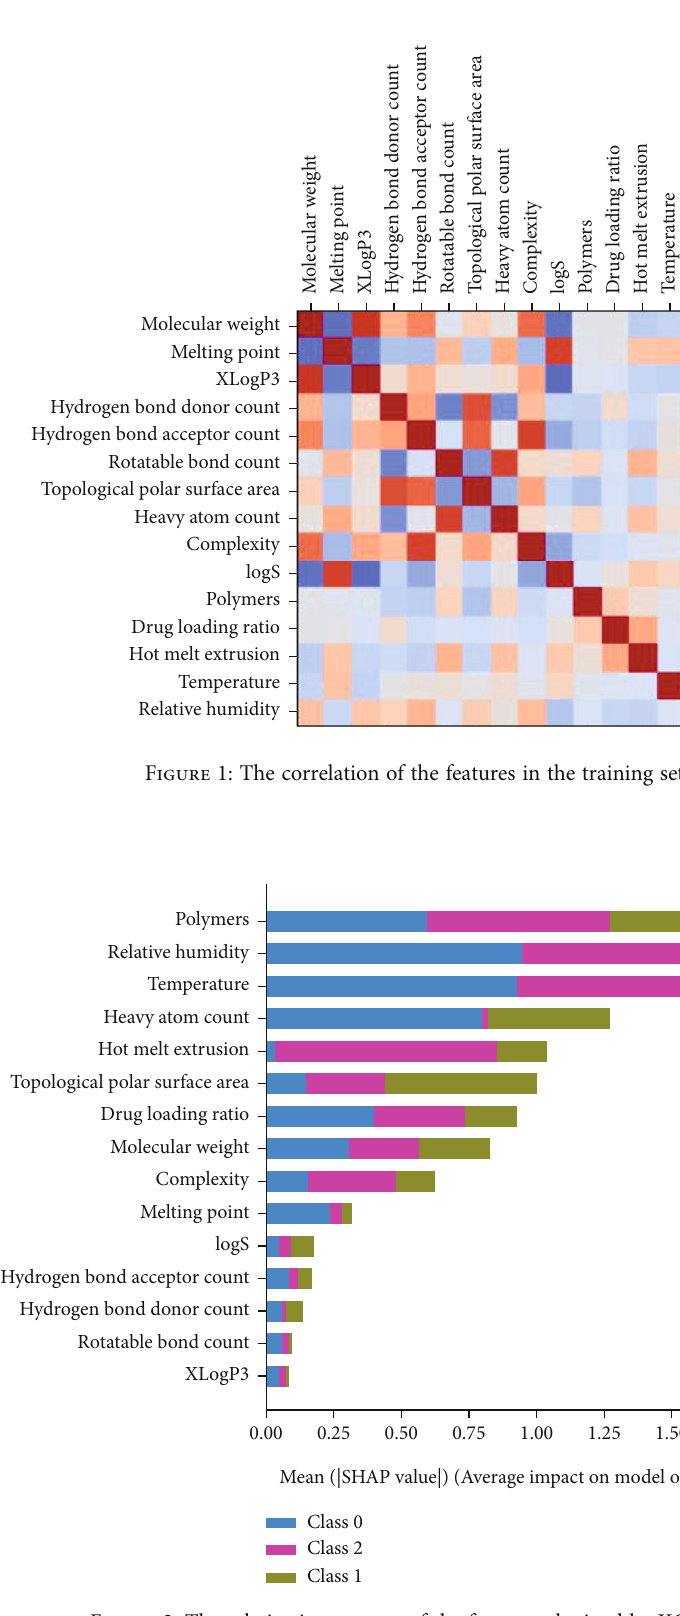
Figure 2: The relative importance of the features obtained by XGBoost.